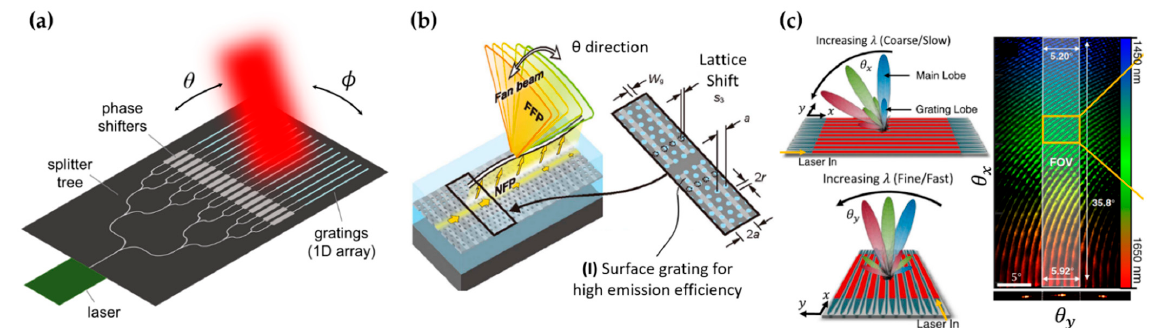
Figure 7. ( a ) Schematic of a 2D beam steerer that uses OPA and dispersive grating diffraction to steer in the φ and θ directions, respectively. Adapted with permission from [12] © The Optical Society. ( b ) Schematic of a beam steerer based on the enhanced angular dispersion of gratings on photonic crystal slow-light waveguides. Adapted with permission from [52] © The Optical Society. ( c ) A beam steerer that steers in both dimensions with dispersive grating diffraction. Adapted with permission from [55] © The Optical Society.